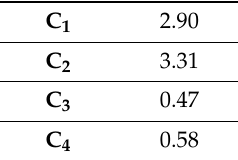
Table 1. Tuned coefficients in Equation (3) for VV-polarization.